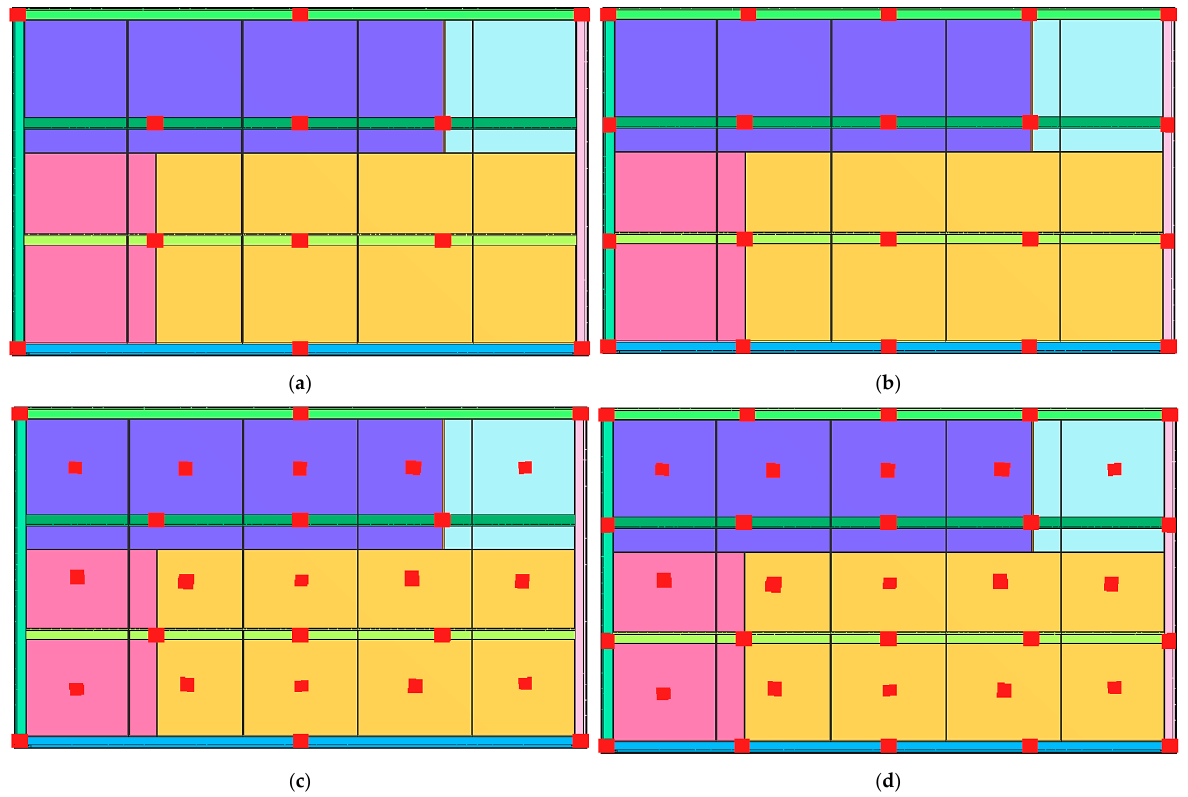
Figure 4. Diagram of the distribution of restraint points in four variants of the numerical simulation of the welding process of the industrial furnace wall panel; ( a ) model 1, ( b ) model 2, ( c ) model 3, and ( d ) model 4.